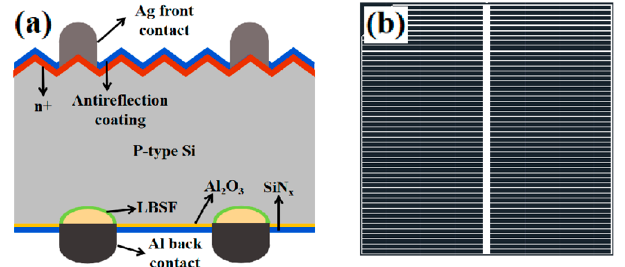
Figure 2. ( a ) Schematic structure of the solar cell fabricated in this study; ( b ) the pattern of firing-through paste screen-printing on the rear side.